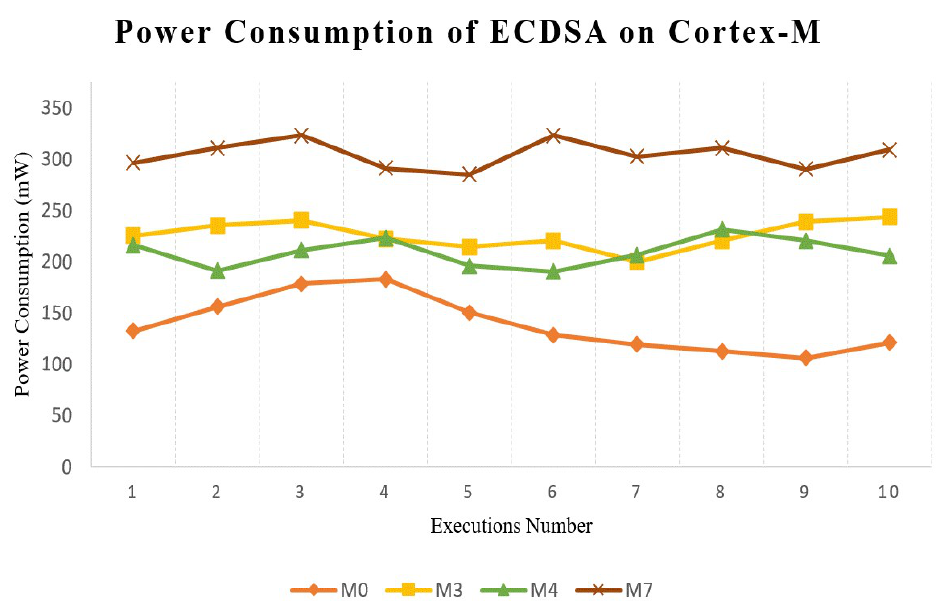
Figure 6. Consumption for each